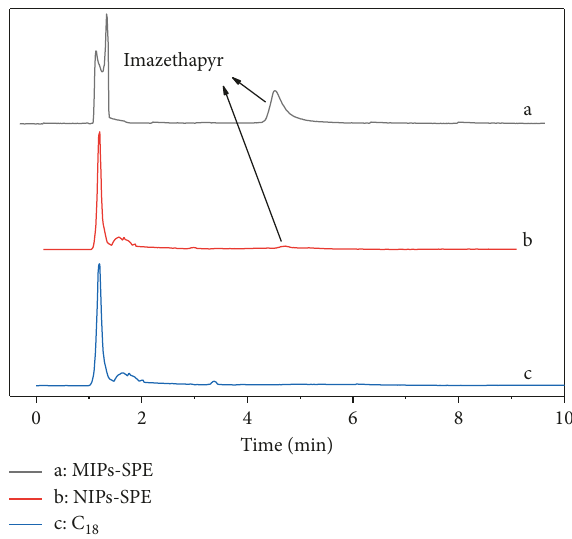
Figure 11: The chromatograms of soil samples with spiked ima- zethapyr (0.05 μ g/g) for MIPs-SPE cartridge (a), NIPs-SPE car- tridge (b), and C 18 -SPE cartridge